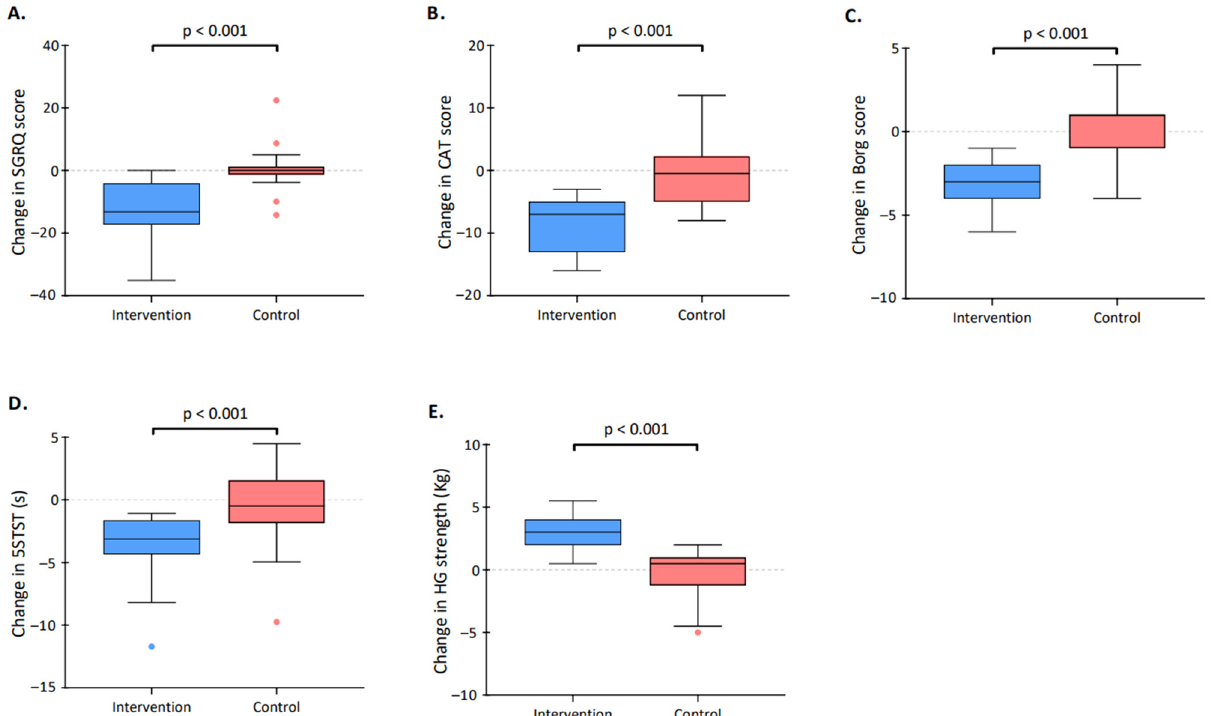
Figure 2. Change in clinical parameters over the study period. The figure describes the pre–post difference in both the control group (red) and the intervention group (blue) for the ( A ) Saint George’s Respiratory Questionnaire (SGRQ) score; ( B ) COPD assessment test (CAT) score; ( C ) Borg score; ( D ) five repetitions of the sit-to-stand test (5STST); and ( E ) handgrip (HG) strength. The boxes indicate the 25th and 75th percentiles; horizontal lines within boxes indicate the median; whiskers indicate the highest and lowest values within the 1.5 × interquartile range; and dots beyond the whiskers indicate